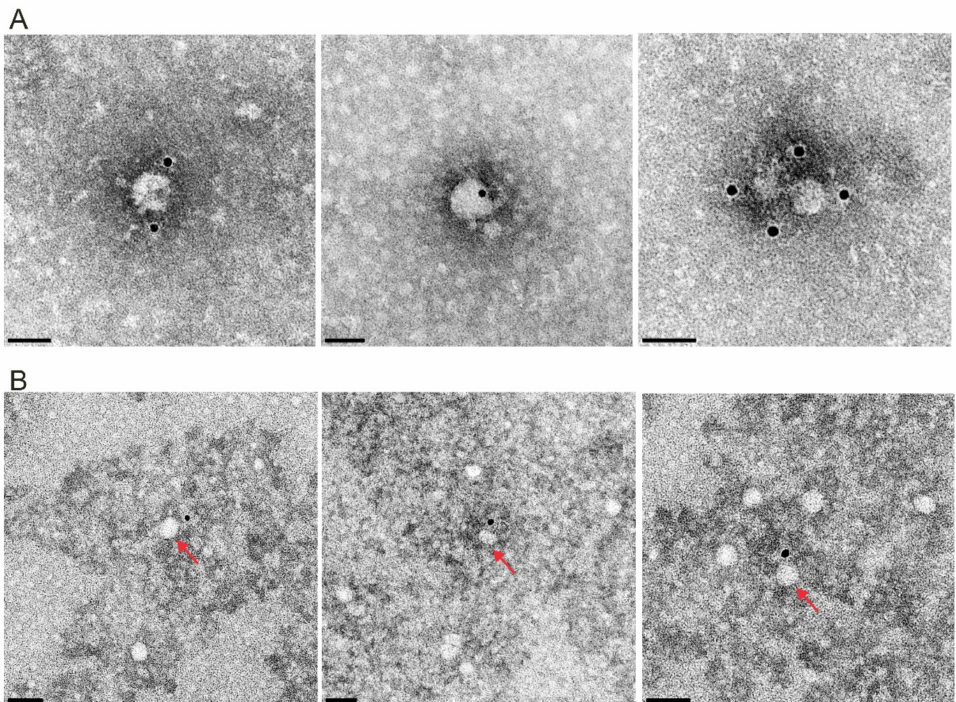
Figure 12. Electron microscopic pictures of immunogold-labelled pestivirus particles and enriched vesicles. CSFV particles enriched from the supernatant of infected SK6 cells by centrifugation ( A ) or vesicles enriched from supernatant of SK6TO_E rns induced with doxycycline were analyzed by immunogold-labelling using E rns specific mab 24/16 and gold-labelled secondary antibody. In ( B ) vesicles with gold grains are highlighted with red arrows. Bars represent 50 nm.